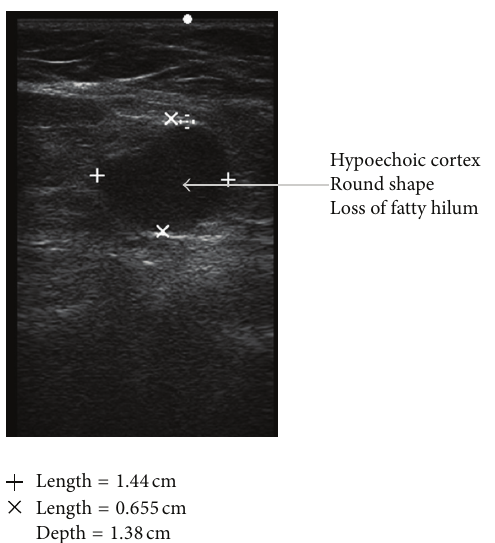
Figure 5: Suspicious node: cortical lobulation, cortical thickening, and displaced hilum.